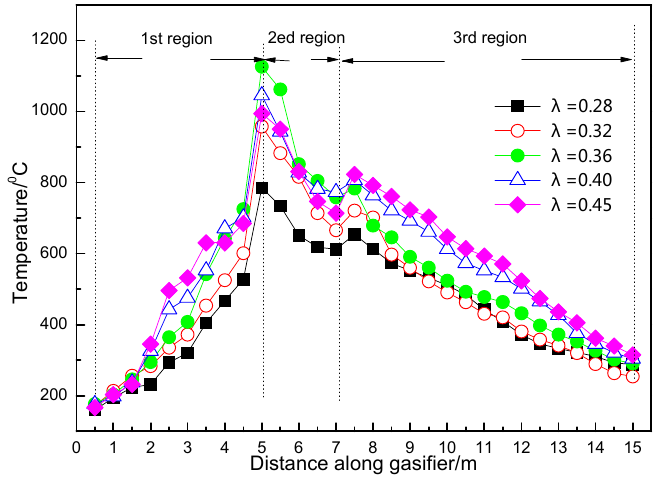
Figure 6. Temperature profile variation with λ .